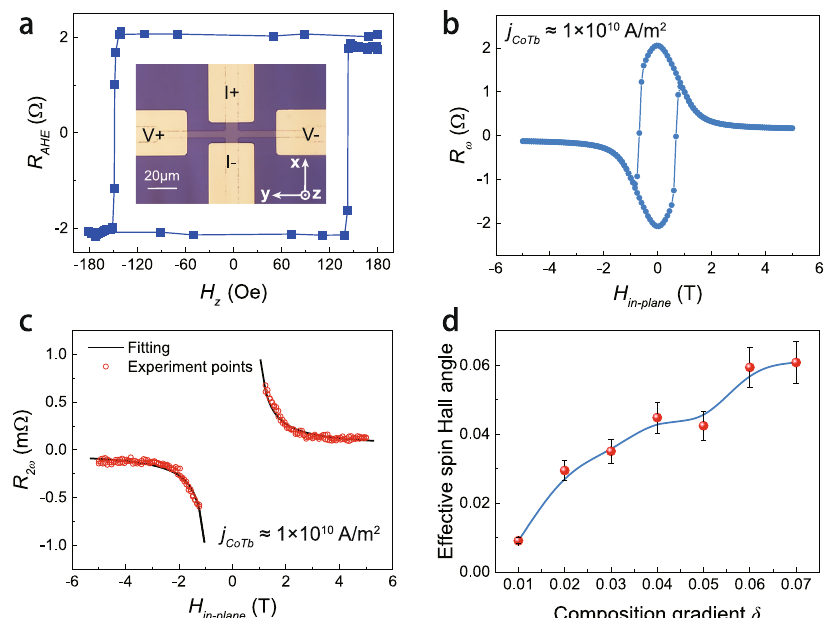
Fig. 2 Electrical measurement setup and SOT characterization. a Measured AHE loop for the sample with δ = 0.06. The square shape reveals that the samples are perpendicularly magnetized. Inset shows a photograph of a representative Hall bar device. b R ω versus magnetic fi eld along the x direction, for the sample with δ = 0.06. c R 2 ω and the fi tting line versus magnetic fi eld along the x direction for the sample with δ = 0.06 under j CoTb ≈ 1 × 10 10 A/m 2 . d Increasing tendency of θ DL versus composition gradient δ . Error bars are calculated from R 2 ω measurements under different current densities for each